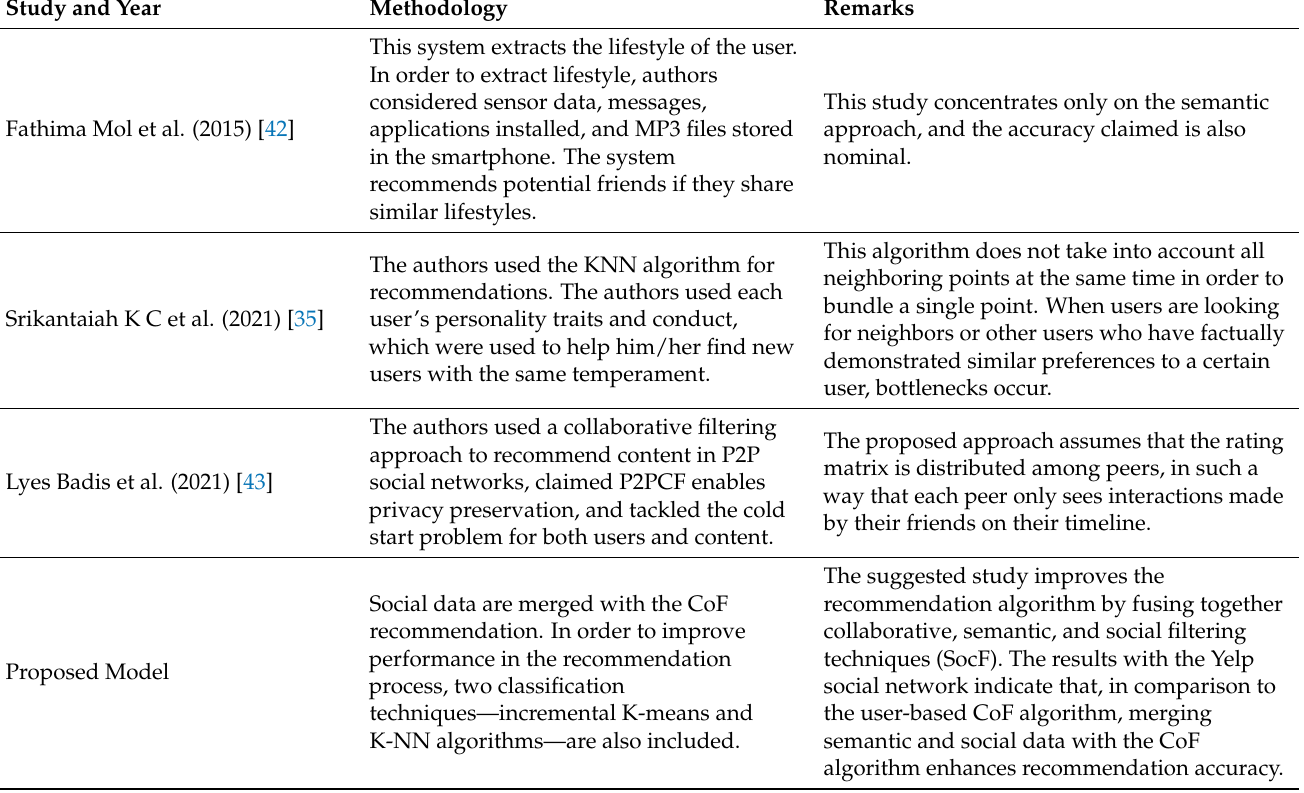
Table 4. Comparison of proposed with existing